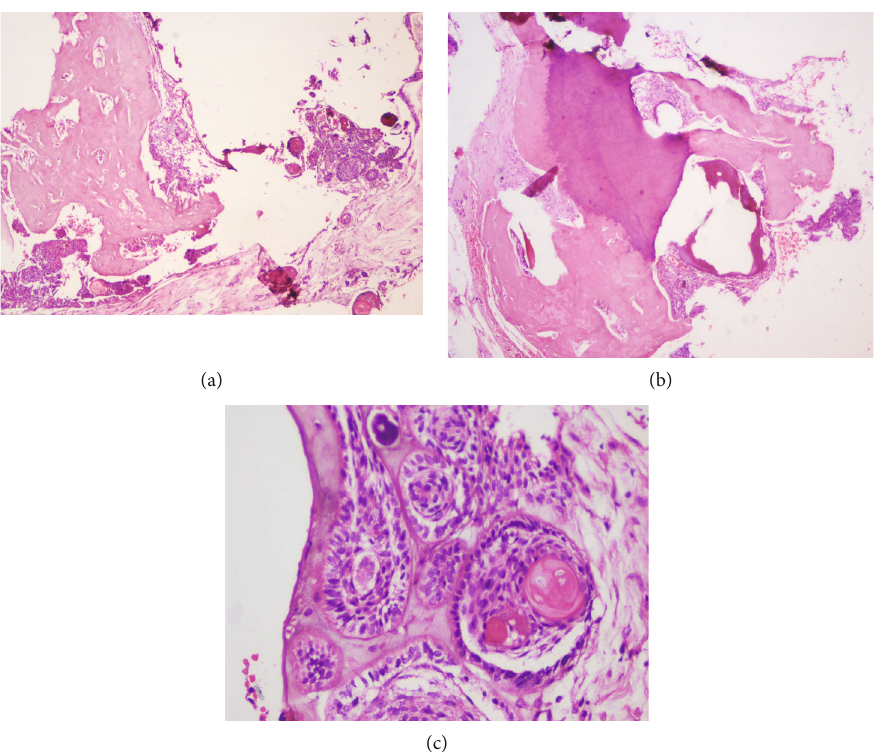
Figure 8: (a) Cystic lesion with epithelium showing ameloblastic change and large areas of dentinoid induction (H&E stain, × 40). (b) Dentin with predentin-like areas in the connective tissue (H&E stain, × 40). (c) Odontogenic epithelium is seen as small and large ameloblastic follicles with entrapped ghost cells (H&E stain, ×